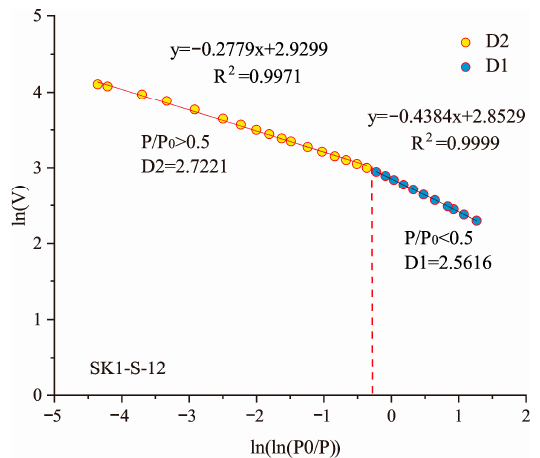
Figure 5. Fractal calculation results (intercept: A of Equation (4)) from FHH model (Equation (3)) of N 2 adsorption at low temperature for sample SK1-S-12 from K 2 n 1+2 of the Songliao Basin, NE China.